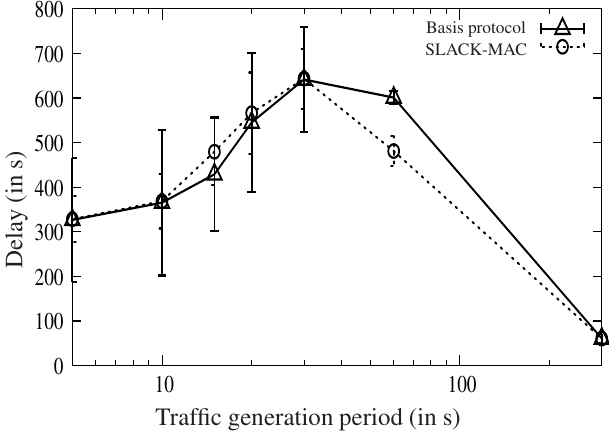
Figure 12. End-to-end delay of data packets as a function of the traffic generation period, for a duty-cycle of 1%, and for the Basic protocol and